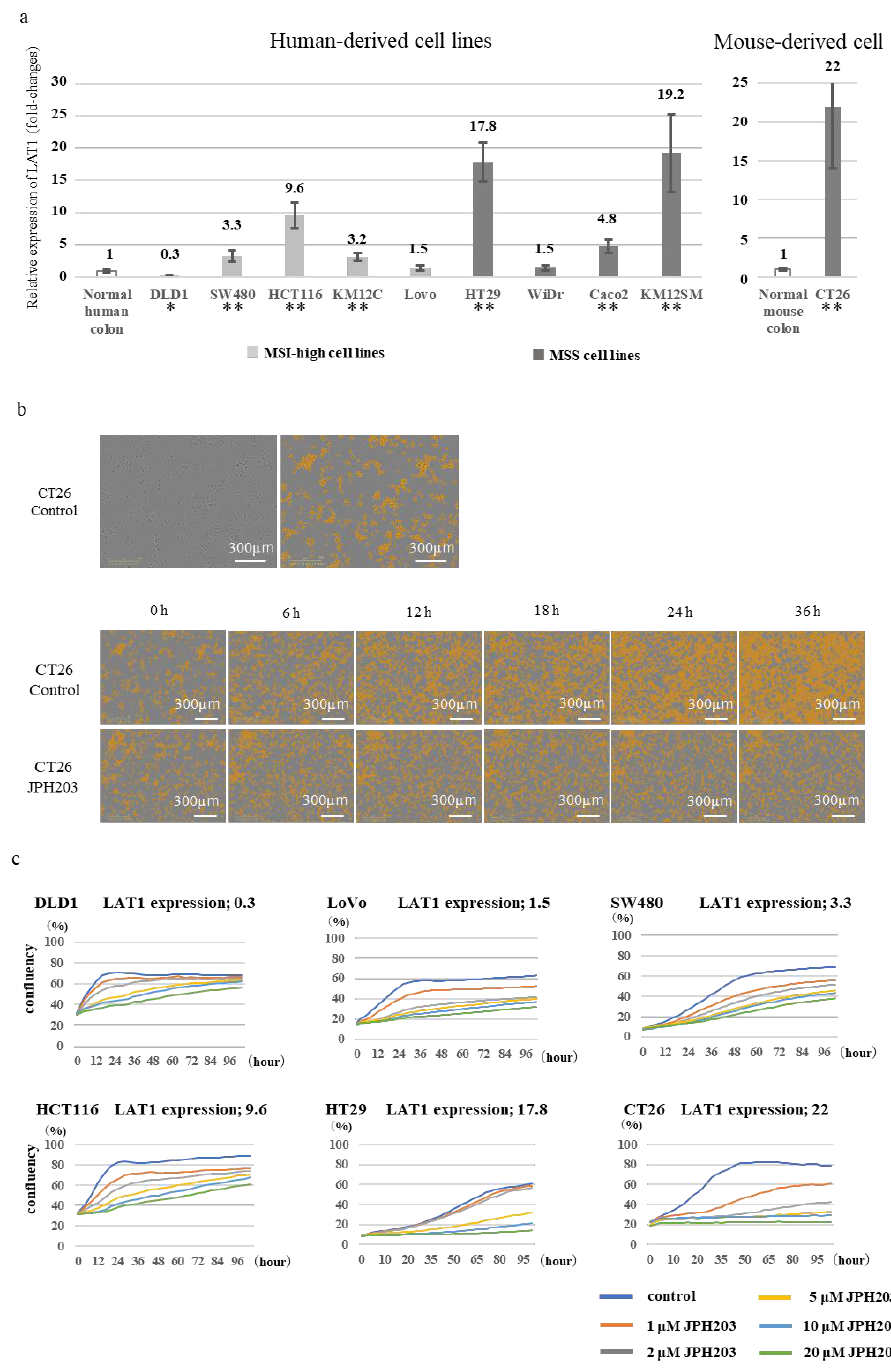
Figure 2. Expression of LAT1 in various cell lines, and the effect of the LAT1 inhibitor JPH203. ( a ) Relative LAT1 mRNA expression in colorectal cancer cell lines. * LAT1 expression was significantly lower compared to that in normal tissue (Student’s t -test; p < 0.05). ** LAT1 expression was significantly higher compared to that in normal tissue (Student’s t -test; p < 0.05). ( b ) The area of cells is evaluated upon its measurement using Incucyte. The upper panel shows the representative image of cancer cells labeled by the Incucyte software, whereas the lower panel shows the time-lapse image of CT26 cancer cell proliferation with and without JPH203 exposure (Drug concentration: 1 µ M). ( c ) Inhibitory effect on cell proliferation by the LAT1 inhibitor JPH203. DLD1 was significantly more inhibited by JPH203 than by 20 μM (Student’s t -test; p < 0.05). Lovo, SW480, HCT116, and CT26 were significantly more inhibited by JPH203 t han by 1 μM (Student’s t -test; p < 0.05). HT29 was significantly more inhibited by JPH203 than by 5 μM (Student’s t -test; p < 0.05).